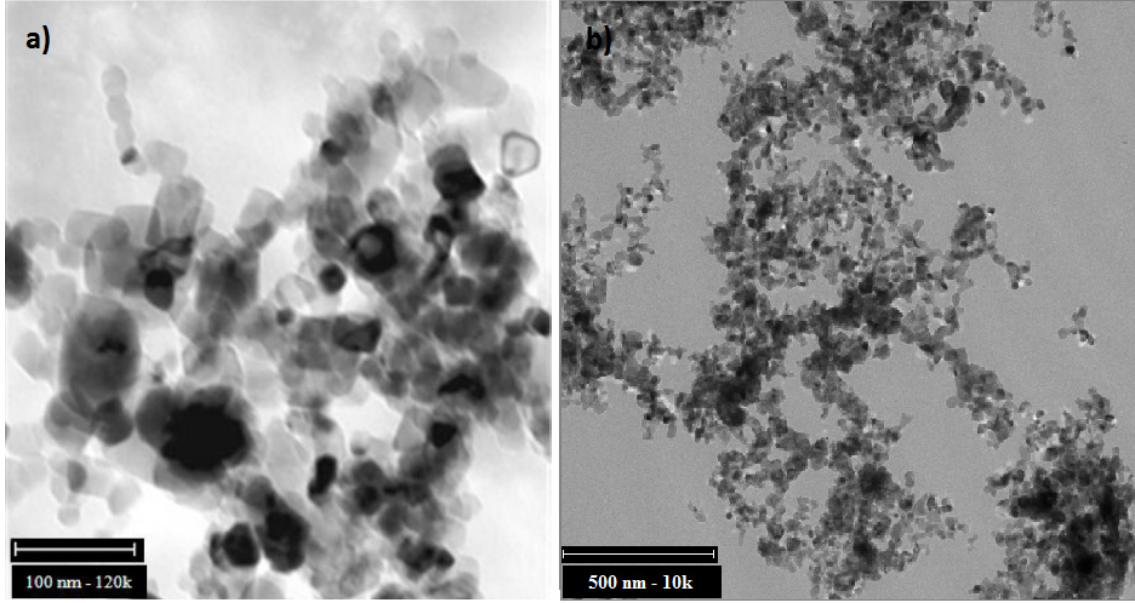
Figure 2. TEM images for nanopowders: ( a ) Aeroxide P25 (TiO 2 ) [11]; ( b ) TiO 2 − x N y (NaBond Technologies Co., Shenzhen,